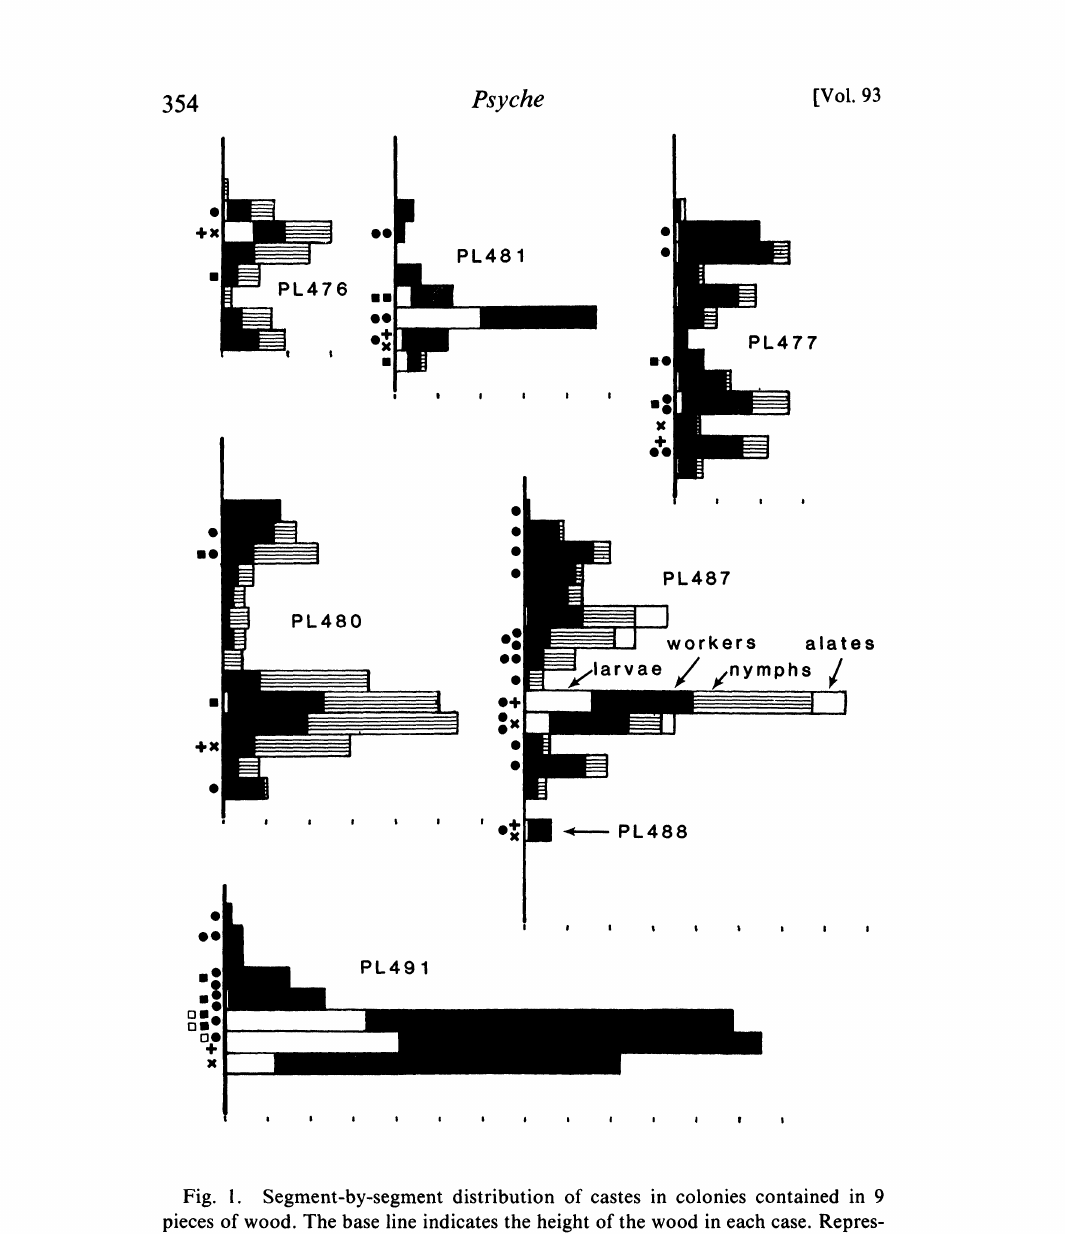
Fig. 1. Segment-by-segment distribution of castes in colonies contained in 9 pieces of wood. The base line indicates the height of the wood in each case. Repres- ented on the left side of each colony are the numbers of individual soldiers (solid symbols) and presoldiers (open symbols)--circles, small soldiers and